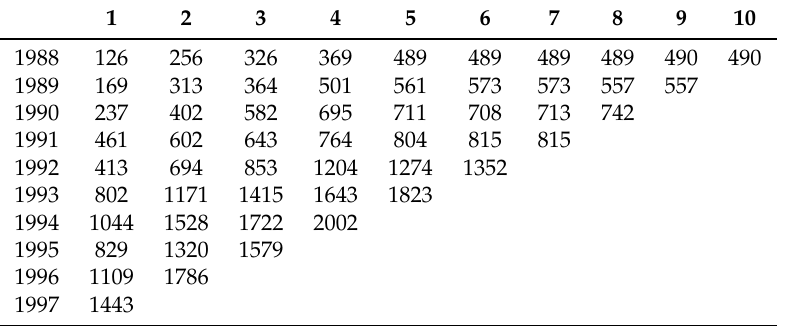
Table 5. Cumulative paid loss triangle observed in the past (commercial auto data set, group code 8079).